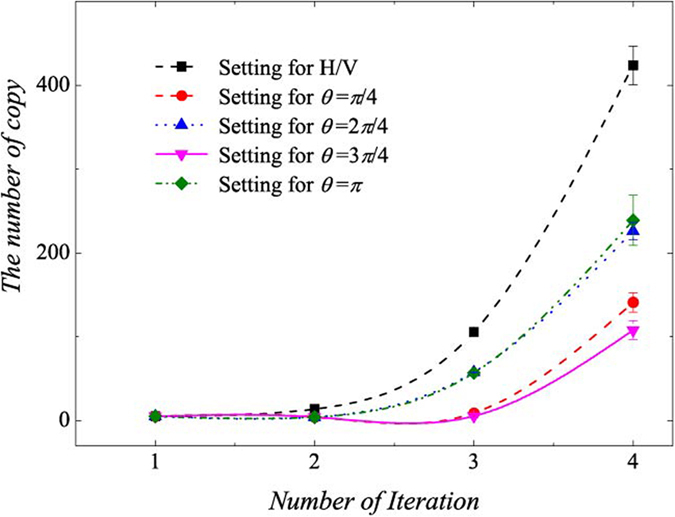
The change of optimization number of copy of ρ4qubits of fidelity estimation corresponding to different iteration numbers with different settings.π/4, 2π/4, 3π/4, and π. “Setting for H/V” represents the number of copy of ρ4qubits projected into S3qubits,1. “Setting for θ = π/4” represents for S4qubits,2, “Setting for θ = 2π/4” represents for S4qubits,3, “Setting for θ = 3π/4” represents for S4qubits,4, “Setting for θ = π” represents for S4qubits,5. Error bar represents one standard deviation.